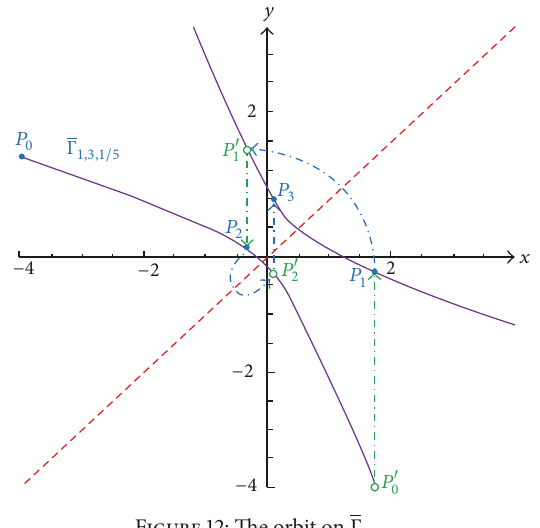
Figure 12: The orbit on Γ 1,3,1/5